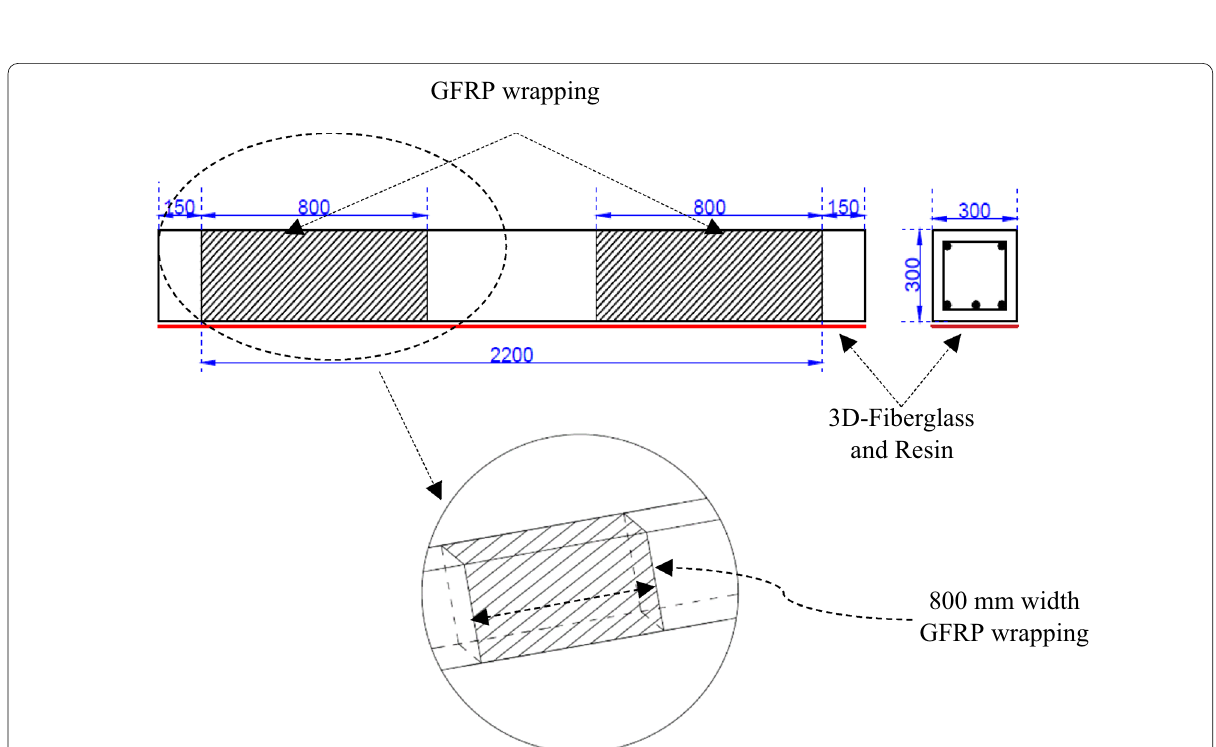
Fig. 4 Details of R3DTR specimen (dimensions in